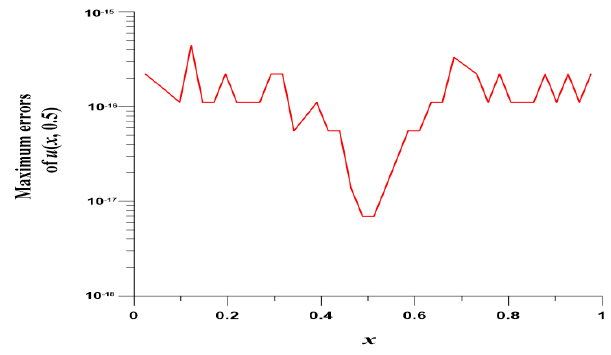
Figure 8. For Example 4: ME( u ) versus t in the time interval.